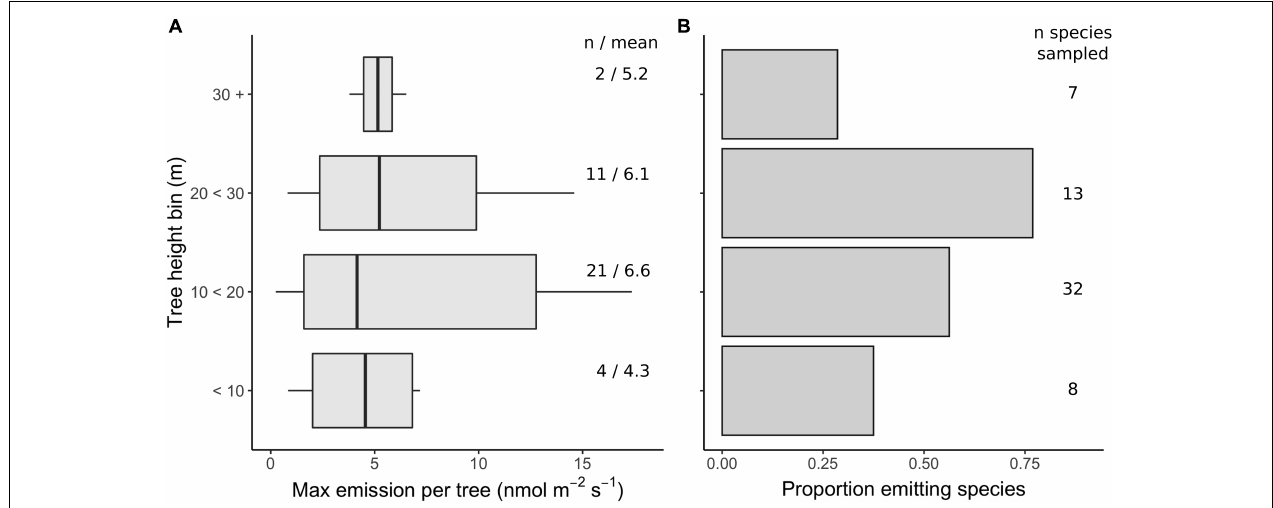
FIGURE 15 | Isoprenoid emission capacities peaked in the mid-canopy among strongly emitting species (those with maximum emission rates > 1 nmol m − 2 s − 1 ). Boxplots in (A) show the highest detectable leaf-level emission rate measured per tree among trees binned by height (typically 1–3 leaves measured per tree, standardized at 3.5 min, 1000 PAR, and 30 ◦ C). Strong emissions are even observed in the understory. Bars in (B) show the proportion of species with emission rates > 1 nmol m − 2 s − 1 , binned by the maximum tree height among measured individuals of each